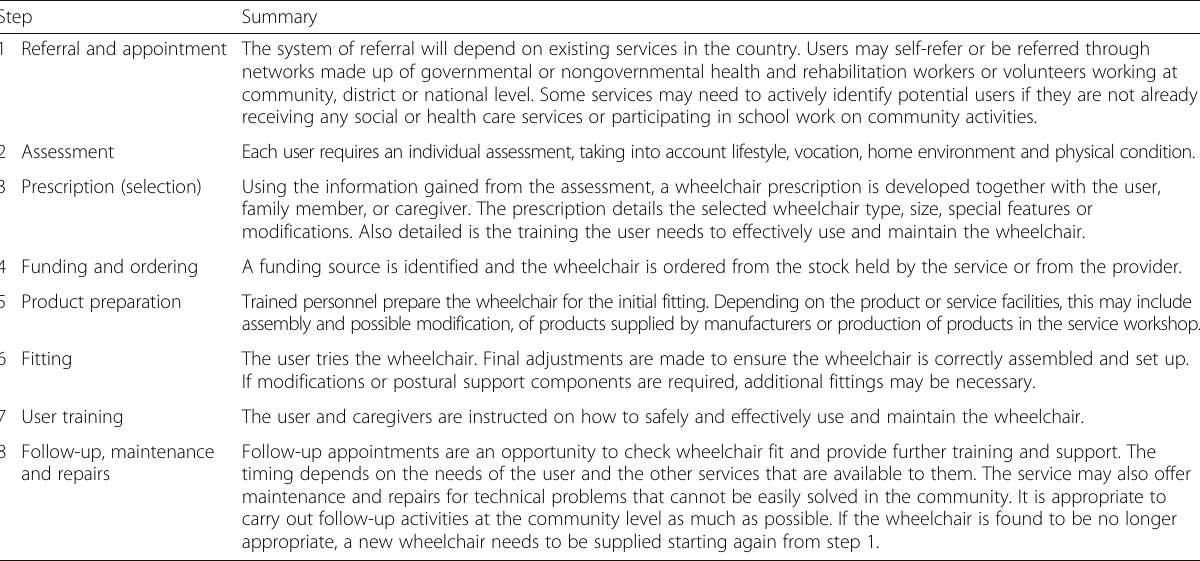
Table 1 Wheelchair Service-Delivery Steps. Reprinted with permission from Guidelines on the provision of manual wheelchairs in less resourced settings